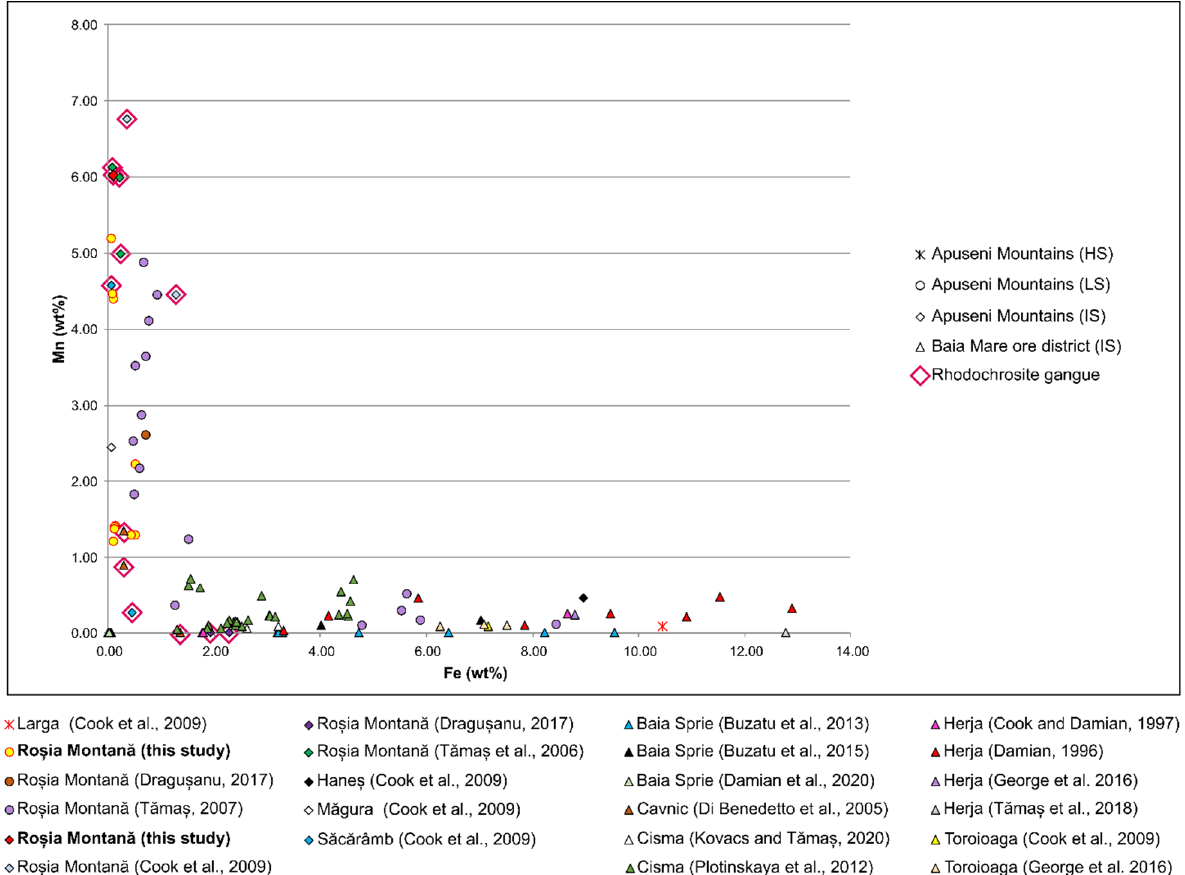
Figure 7. Plot of Mn vs. Fe (in wt%) in sphalerite from Romanian LS, IS, and HS epithermal ore deposits. The new data for the Ros ia Montan ă ore deposit and the published EPMA data on , sphalerite from the LS, IS, and HS ore deposits in the Apuseni Mountains (Table S1— supplementary material) [6,35,46,47] and the Baia Mare district (Table